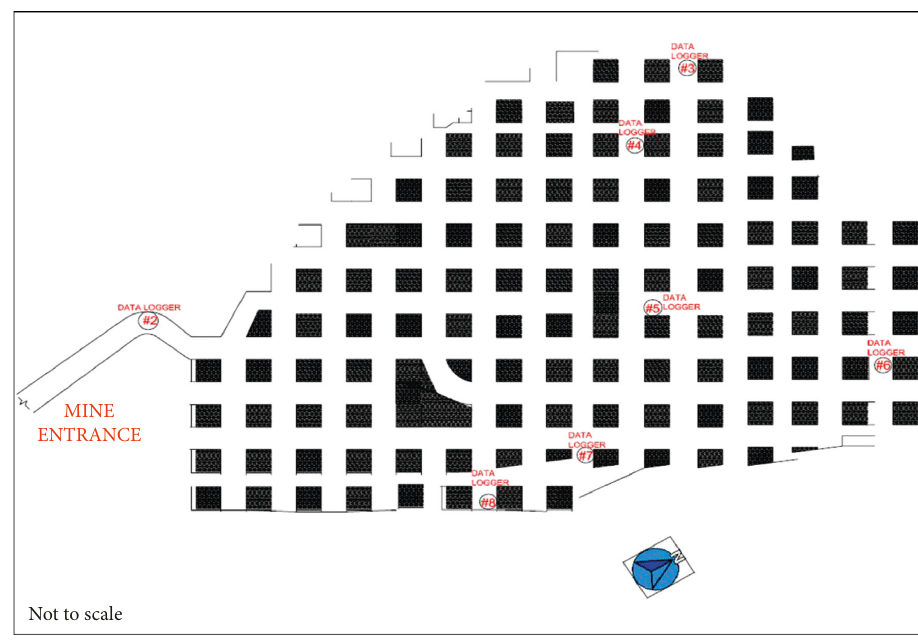
Figure 5: Location of data loggers.